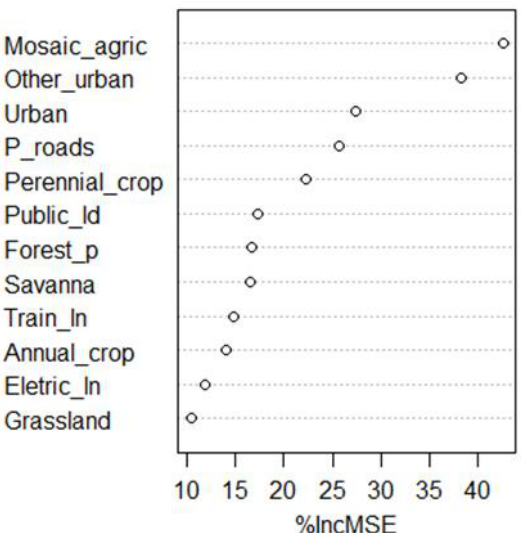
Figure 5. Percentage increase in the Mean Square Error (IncMSE) of the explanatory variables selected in the Random Forest (RF) model. The higher the IncMSE, the larger the contribution of that variable to the model.